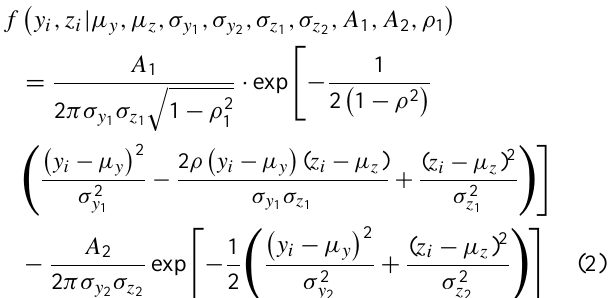
Figure 3. Example of extended bivariate function (Eq. 2) for equal parameters µ y , µ z , σ y values as ρ =− 0.9, ρ = 0, and ρ = 0.9, respectively, from left to right. Top panels represent the wake speed deficit and bottom panels the contour